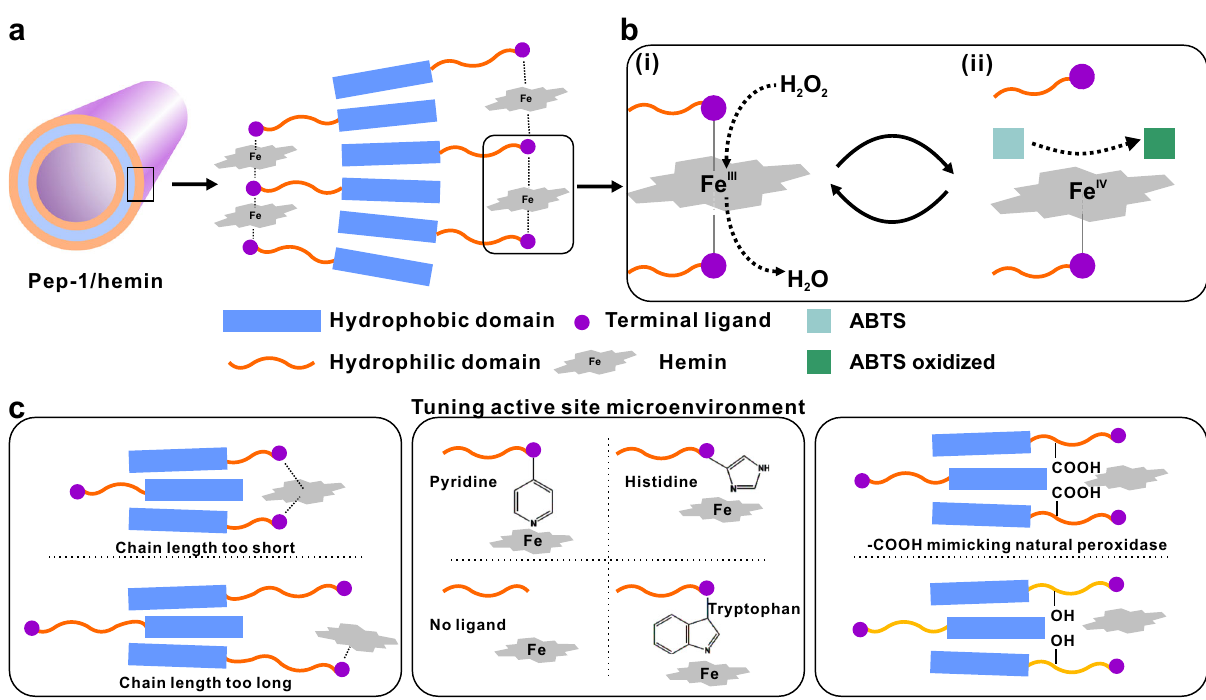
Fig. 5 Schematic representation of systematic tuning of peptoid/hemin assemblies toward their catalytic activities and a proposed reaction mechanism. a Pep-1/hemin nanotube and the proposed assembly mechanism. b Catalytic mechanism showing the ping-pong pathway for the oxidation of ABTS. c Tuning microenvironments of peptoid/hemin catalyst in terms of chain length, terminal ligand, and side